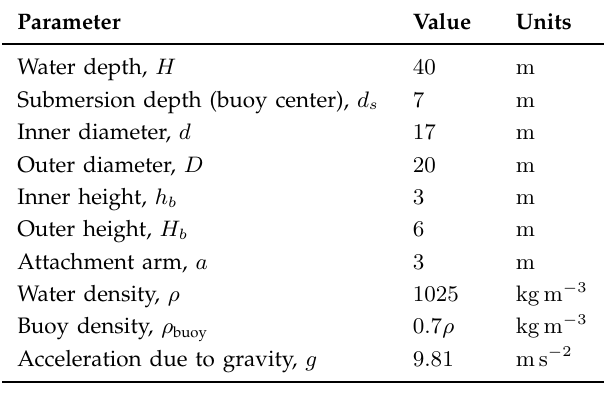
These physical quantities as well as some general quantities used in the simulations are listed below in Table I, and the drag properties based on [25] for a buoy of this shape is given in Table II. TABLE I S IMULATION P ARAMETERS